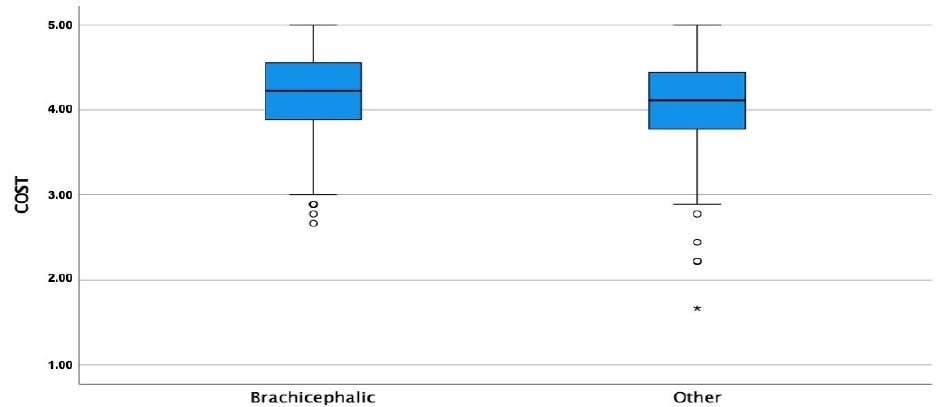
Figure 2. Comparison of emotional closeness subscale (EC) means between brachycephalic and non-brachycephalic breeds. Dots represent weak outliers.